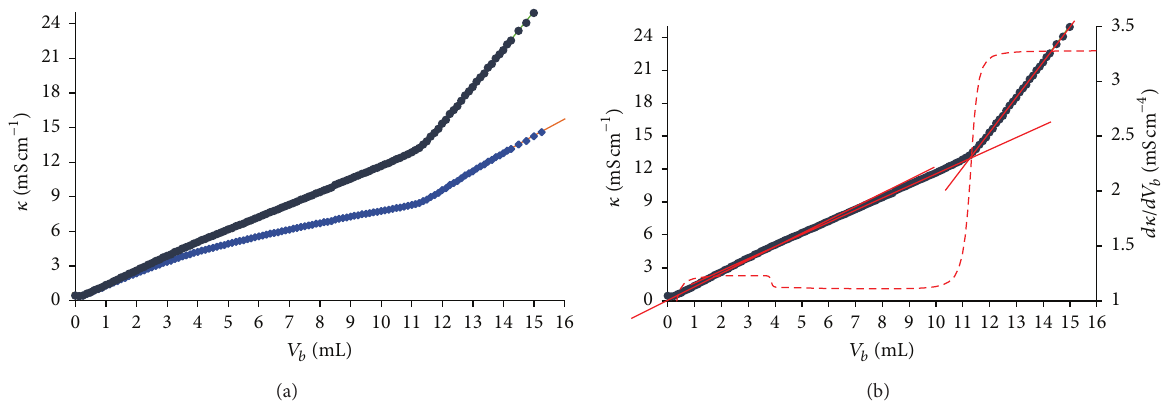
asafunctionof 𝑉 𝑏 forthetitrationsystemstatedinFigure 4.(a)Theconductivityplotsofthesystemandcorrected corr